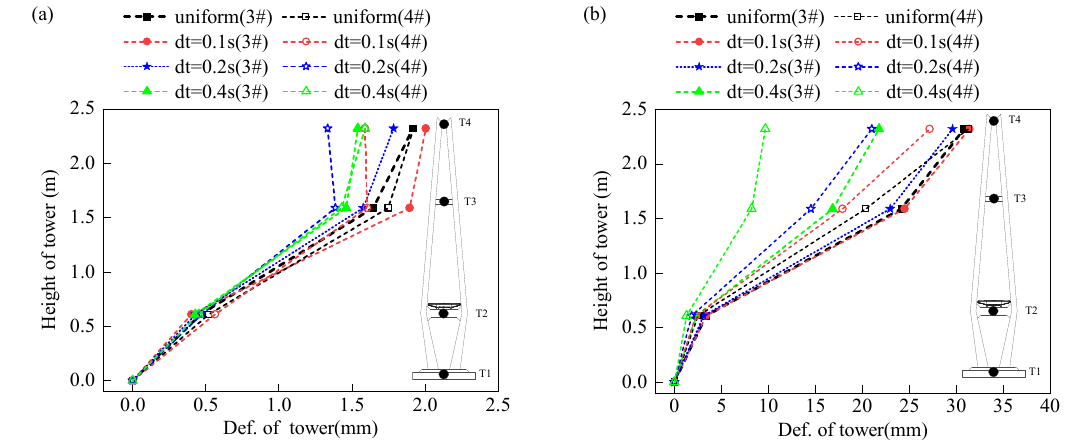
Figure 26. Relative displacements response of towers subjected to ( a ) ScEL ( b ) ScTCU.